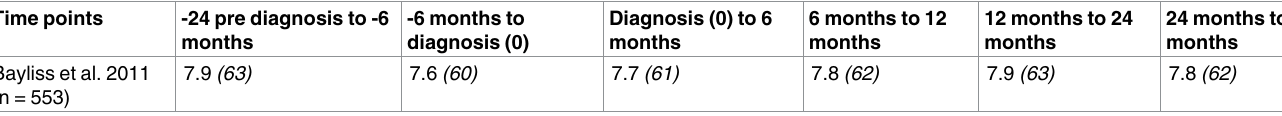
Table 4. Median percent (%) HbA1c across study time